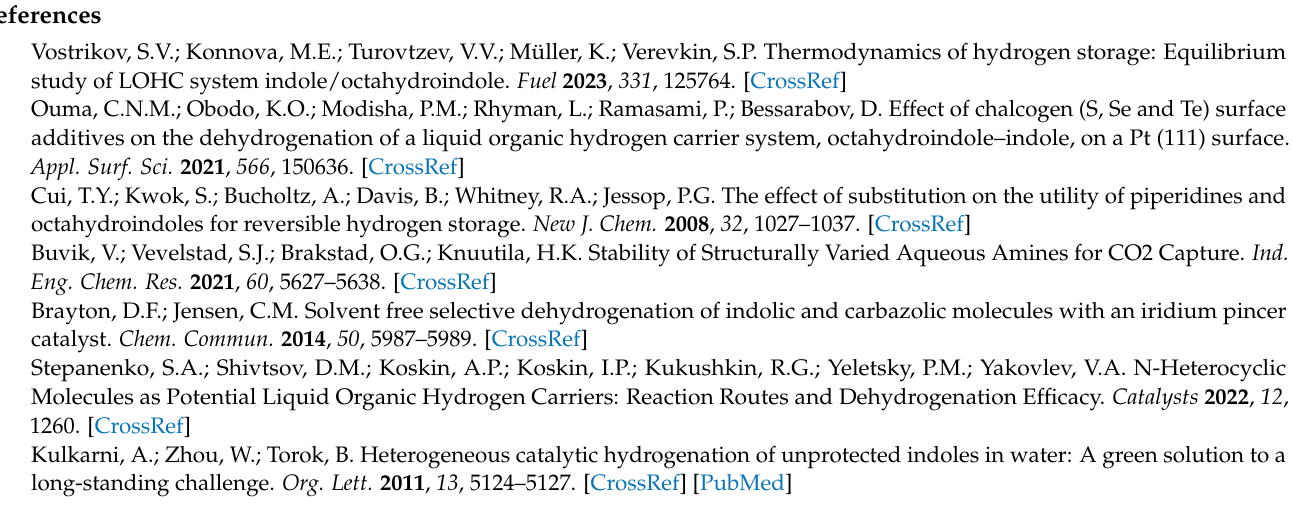
Table S4: Results of transpiration method for indole derivatives: absolute vapor pressures p , standard molar vaporization enthalpies and standard molar vaporization entropies; Table S5: Compilation of data on molar heat capacities C o p , m (liq) and heat capacity differences; Table S6: Experimental enthalpies calculated by using quantum-chemical methods for 1-methyl-indole; Table S8: Reac- tions and reaction enthalpies calculated by using quantum-chemical methods for 1-methyl-indoline; Table S9: Reactions and reaction enthalpies calculated by using quantum-chemical methods for H4-1-methyl-indole; Table S10: Reactions and reaction enthalpies calculated by using quantum- chemical methods for cis-H8-1-methyl-indole; Table S11: Reactions and reaction enthalpies cal- culated by using quantum-chemical methods for trans-H8-1-methyl-indole; Table S12: Reference values for ∆ f H o m (g, 298.15 K) used for calculation reaction enthalpies in Tables S7–S11 with help of quantum-chemical methods. Figure S1: Reaction scheme employed to produce 1-methylindoline; Figure S2: NMR spectra of 1-methylindoline; Figure S3: Comparison of vapor pressures for1-methyl- H o m (298.15 K), of H8-1-methyl-indole based indole; Figure S4: Calculation enthalpy of vaporization, ∆ g l on the vaporization enthalpy of H8-indole. References [37–46] are cited in the supplementary